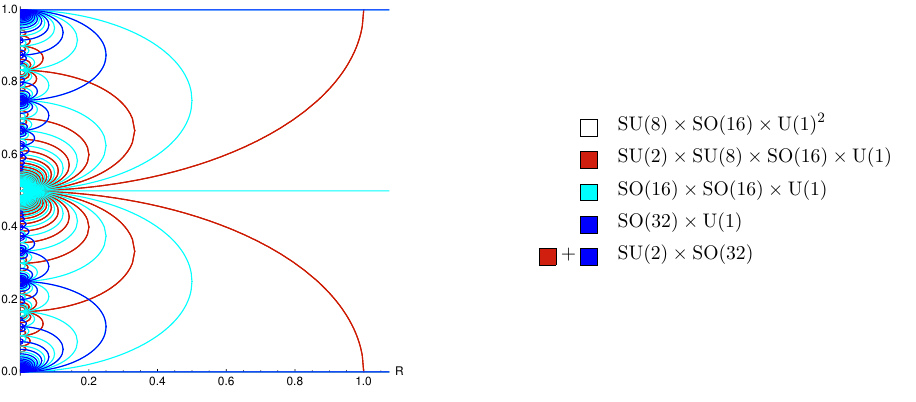
Figure 15. SO(32) heterotic with Wilson line A I = (( A ) 8 ; 0 8 ).